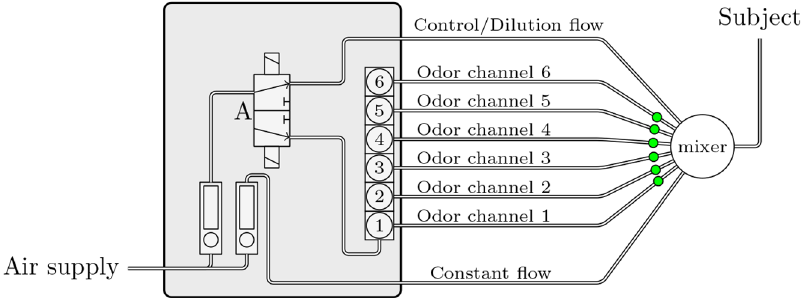
Fig 10. Setting up of a fast three-way valve in case the solenoid valves are too slow. In case the solenoid valves are too slow, the pneumatic system can be improved by adding a fast three-way valve. This valve alternatively supplies the control/dilution channels and odor